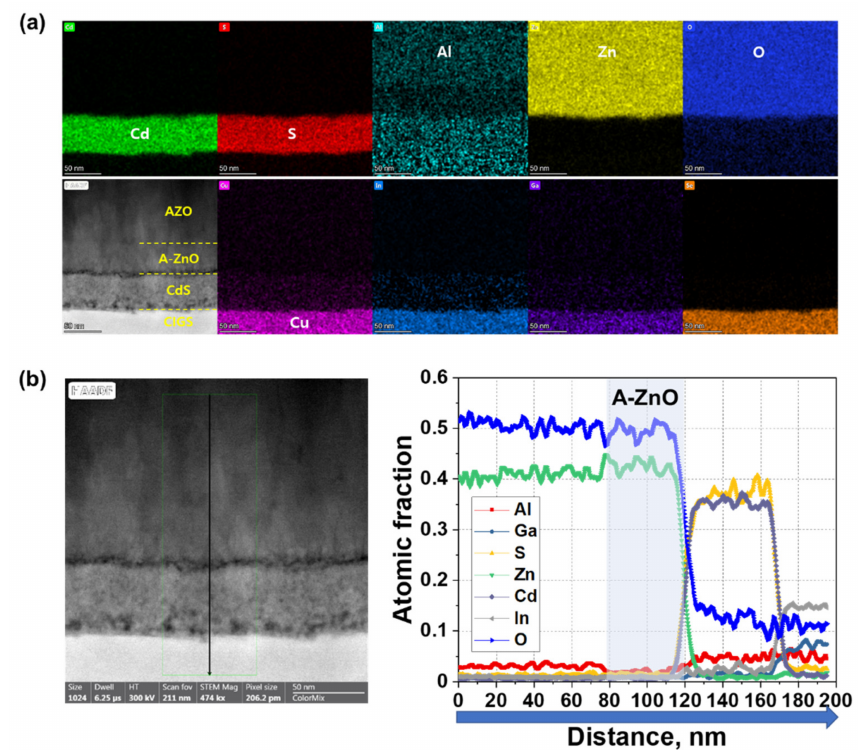
Figure 3. ( a ) Cross-sectional TEM energy dispersive spectroscopy (EDS) mapping images and ( b ) EDS line scan of atomic fraction of elements in the AZO/A-ZnO/CdS/CIGS/Mo/SLG structure of a complete solar cell.